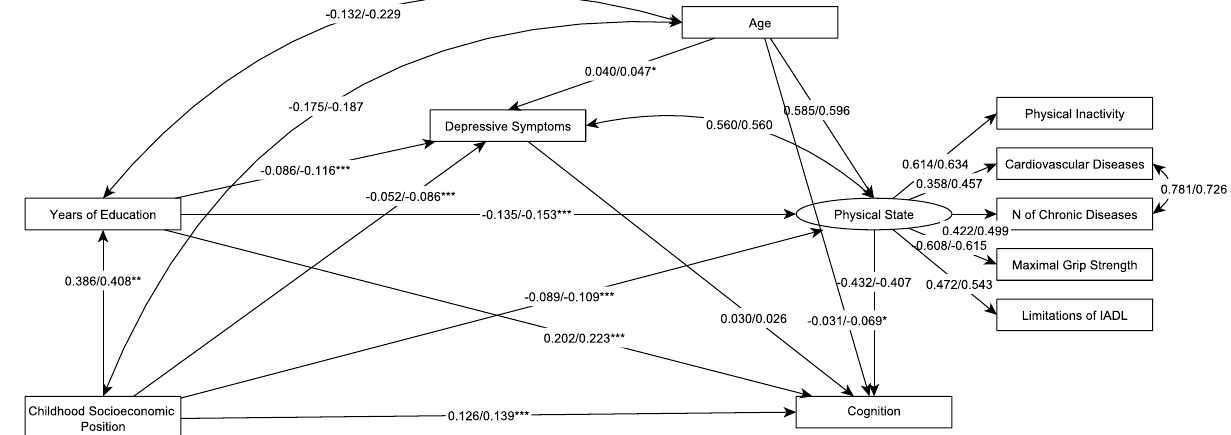
Figure 1. Multiple mediation model. * p < 0.05, ** p < 0.01, *** p < 0.001. The figure presents the analysis testing the mediating effect of education, depressive symptoms, and the “physical state” latent factor on the association between childhood socioeconomic position and the level of cognitive performance controlled for age across sex. Standardized coefficients are presented on their respective arrows. Men’s and women’s coefficients are on the left and right position of the slash, respectively. All the paths are significant at p < 0.001. The paths significantly different between men and women are marked with respective asterisks. The whole mediation model explained 34.6% and 40.1% of men’s and women’s variance in cognition, respectively. The model accounted for data variance’s 14.9% and 16.6% in years of education in men and women, respectively. Depressive symptoms were explained up to 1.7% and 3.6% in men and women,